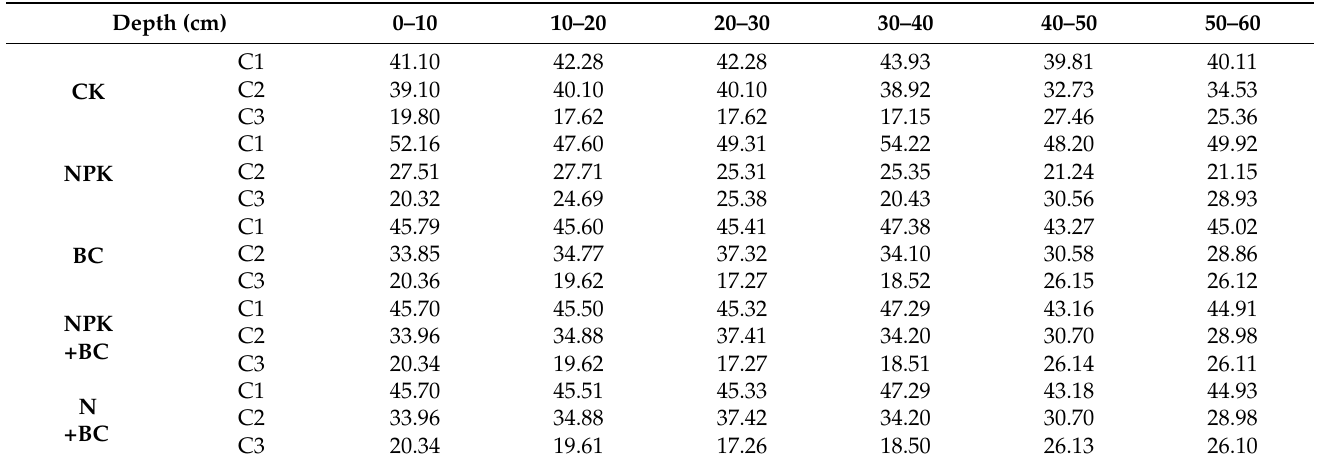
Table 5. The original data of the results in Figure 3 (%).